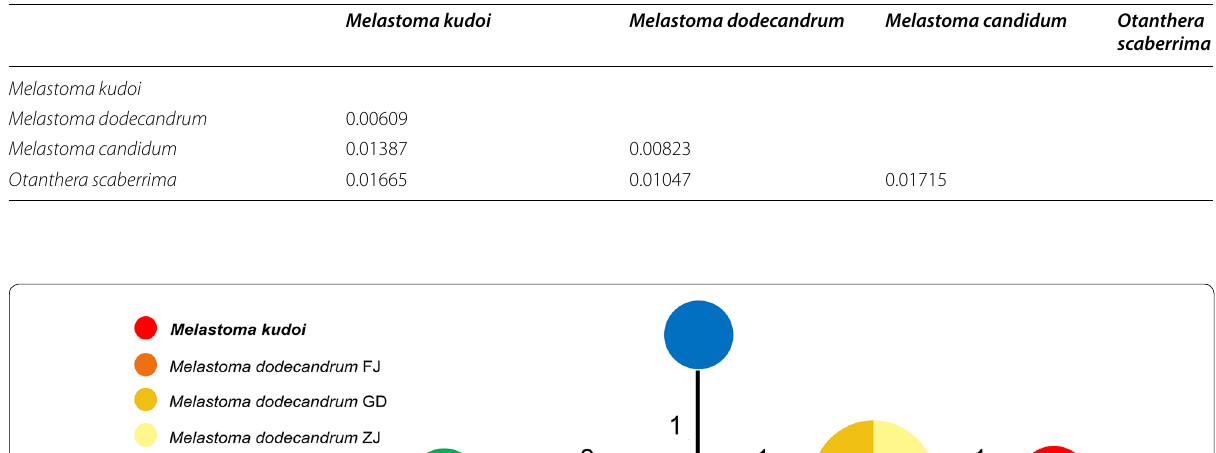
Table 1 Pairwise genetic distances among M. kudoi and three closely related species based on six nuclear genes